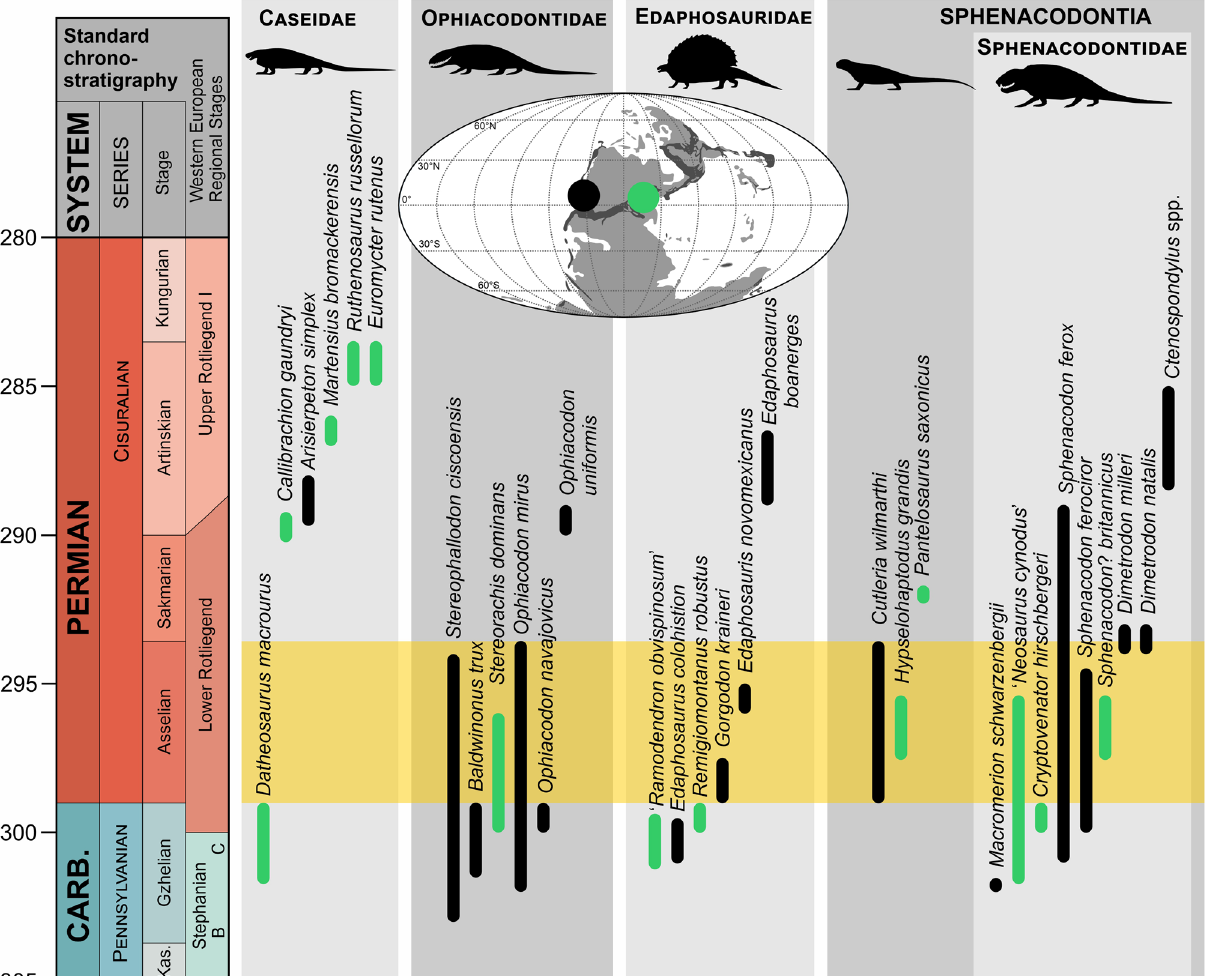
Figure 8. Stratigraphic distribution of medium-to-large-sized early-diverging synapsid species from Europe (green) and North America (black) in the uppermost Pennsylvanian/lower Permian. The time span of the Boskovice Basin is highlighted by orange stripe. The stratigraphic ranges of particular taxa and locality ages are based on Refs. 25,26,99,101–103,109,110 assignment to D. leisnerianus , such as proximodistally prolonged heel impressions, rather low heteropody, increase in the length of digits I–IV, and slightly imprinted proximal part of digits. Some of the tracks settled in the incomplete trackways of MZM Ge 33074 show shorter digit impressions; still, no other features diagnostic for the ichnospecies D. osageorum , such as separated palm impressions in two portions and the strong heteropody have been observed (Fig. 7A, B). Nevertheless, the relatively short digit impressions were also observed in previously described footprints of D. leisnerianus (e.g. Ref. 75 , Fig. 5a; Ref. 78 , Fig. 10; Ref. 96 , Fig. 5b–d). Except for the large number of potential trackmakers, the preservation is also affected by many external factors, including the post-registration erosion, character of the substrate (e.g., inclination, water saturation)